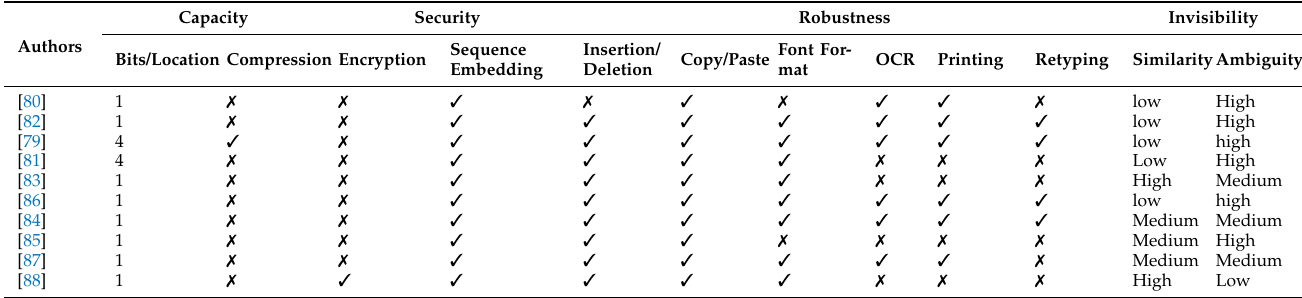
Table 21. Evaluation of diacritics method based on invisibility and robustness and